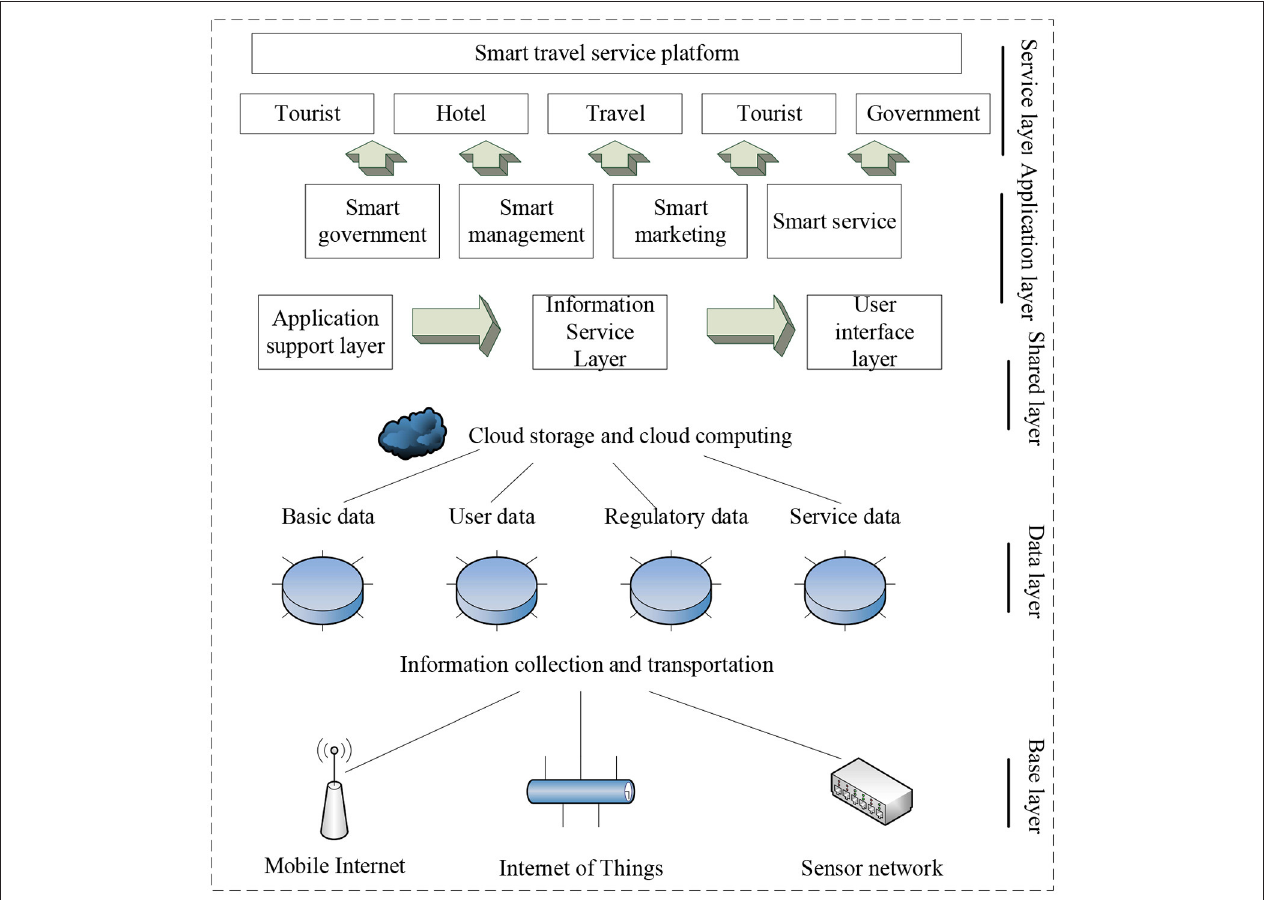
FIGURE 1 | The standard system of smart travel service